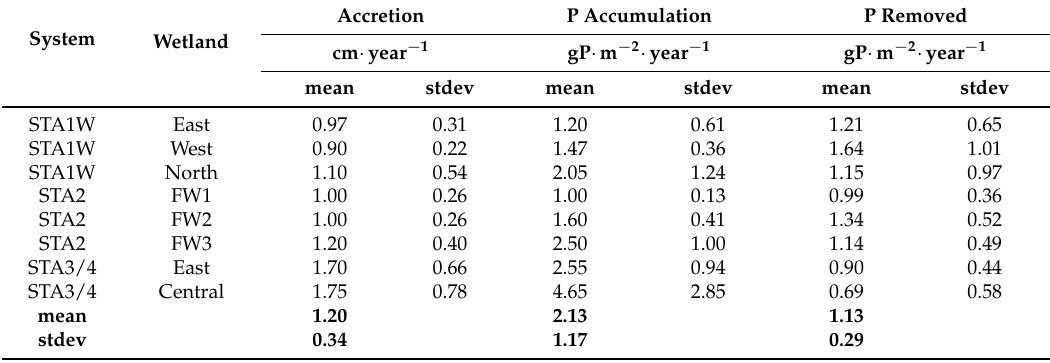
Table 4. Phosphorus accumulation in soils and removed from water in STAs. Accretion and P accumulation were measured at a small number of locations in each wetland for soil cores taken in 2009 [64]. The P removed is calculated from annual performance data for the water entering and leaving the wetlands, which typically spanned the majority of the operating